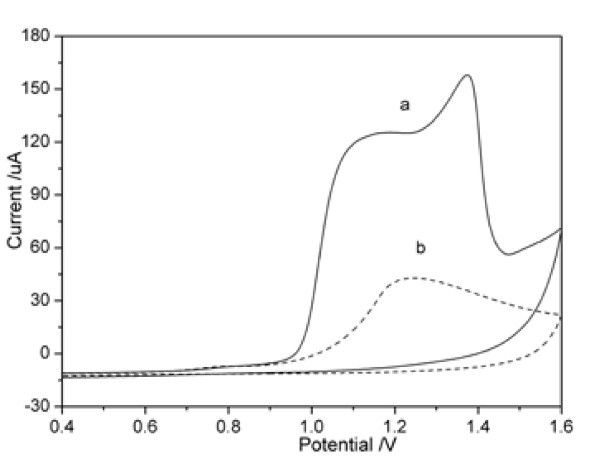
Cyclic voltammograms of Pt in 0.01 M EDOT + 0.1 M KNO3 and 0.01 M EDOT + 0.1 M KCl. Scan rate: 50 mV/s.